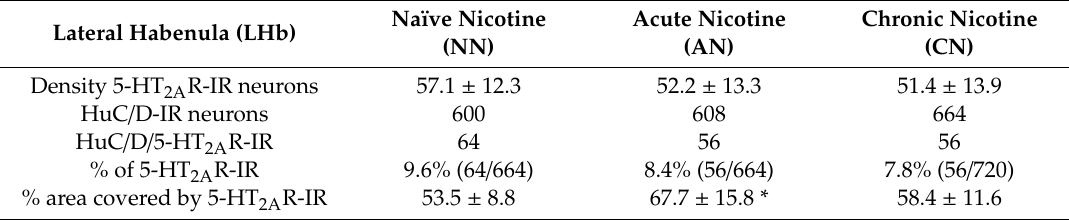
Table 1. 5-HT 2A R-IR somata and colocalization of HuC / D with 5-HT 2A R in the rat lateral habenula.